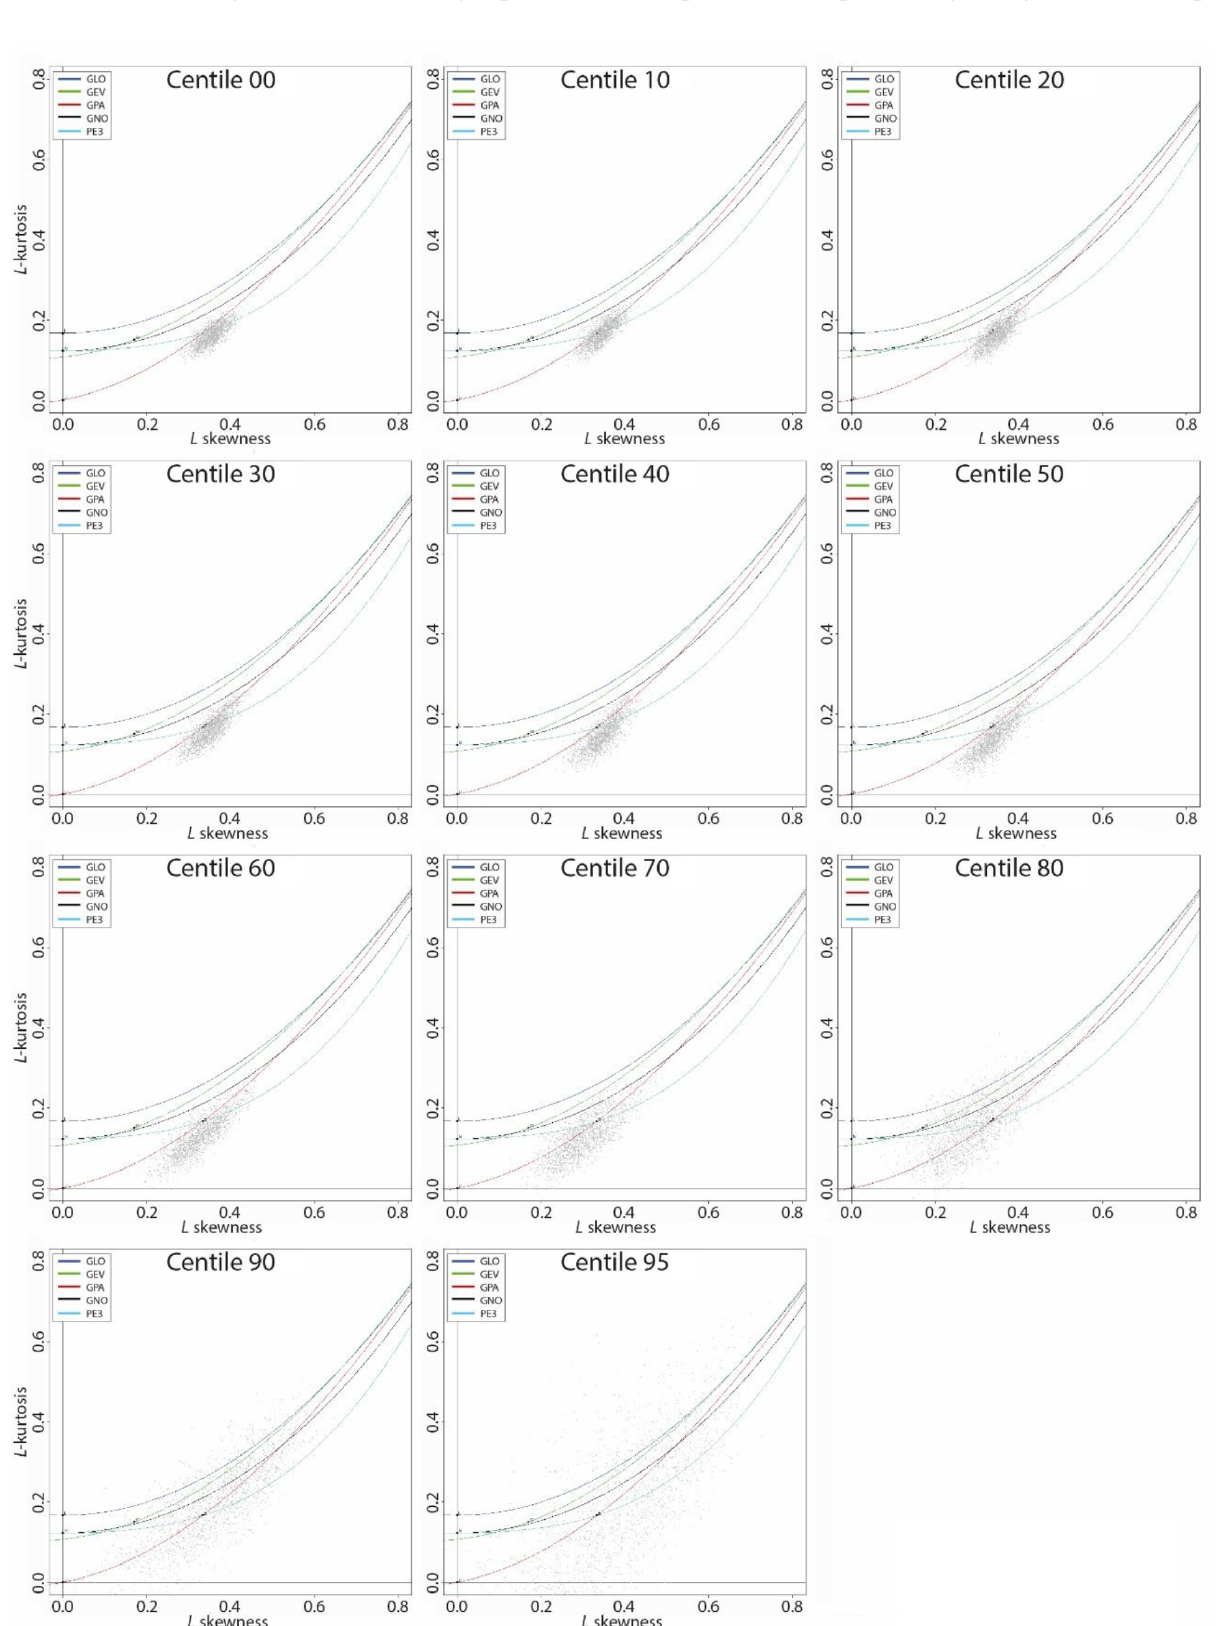
Figure 1. L-moment diagrams for the peak-over-threshold series obtained from the 1-month SPEI duration series. Nat. Hazards Earth Syst. Sci., 19, 611–628,